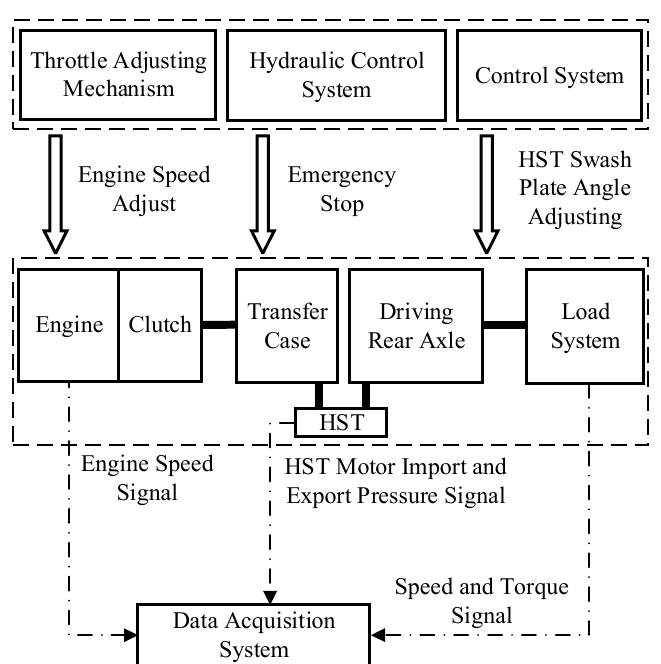
Figure 3. Structural components of the drive system test bench. Note: HST is the abbreviations of the hydrostatic transmission.